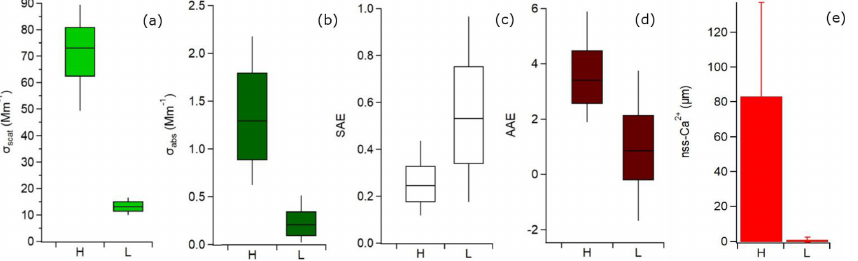
Figure 3. Box plots for periods identified as low and high dust for (a) scattering and (b) absorption coefficients, (c) SAE, (d) AAE, and (e) non-sea salt calcium concentration in cloud water